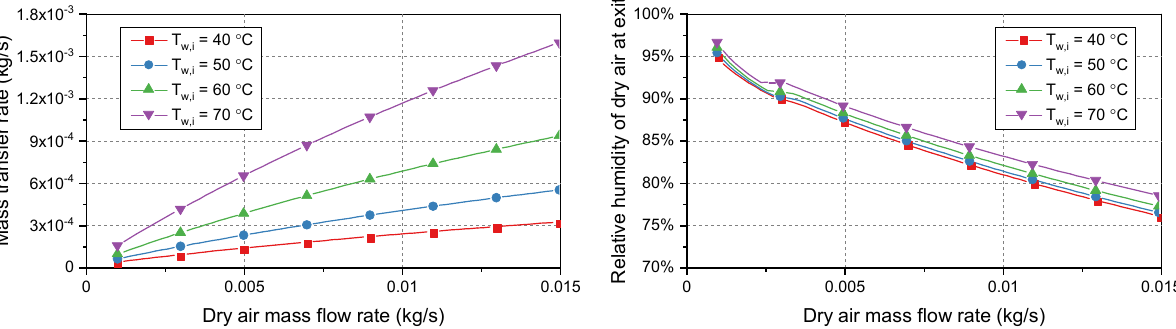
Figure 2. Effects of the operating temperature on the mass transfer rate and relative humidity of dry air.